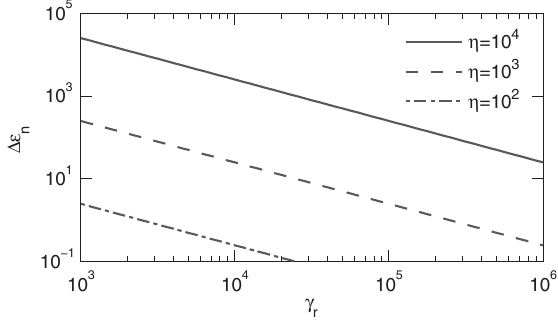
FIG. 4. Relative per-stage emittance